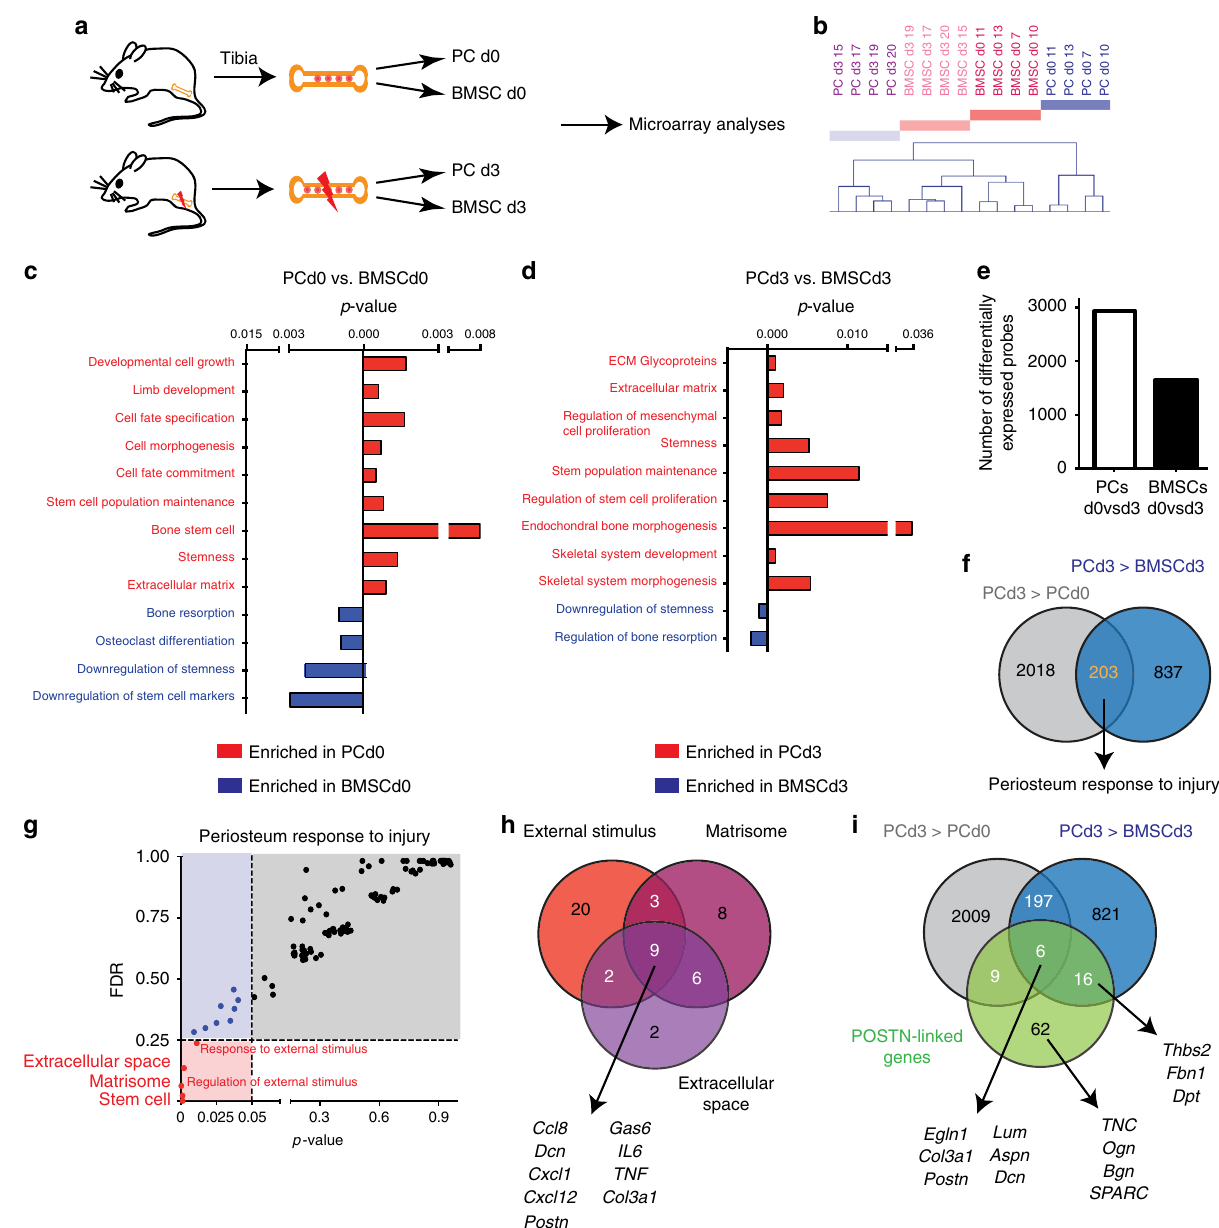
Fig. 4 Microarray analyses of PCs and BMSCs in response to fracture. a Experimental design for microarray analyses of PCs and BMSCs isolated from wild- type un-injured tibias (d0) and from tibias 3 days post fracture (d3) ( n = 4 per group). b Hierarchical clustering of biological replicates. c , d GSEA analyses of PCd0 vs. BMSCd0 and PCd3 vs. BMSCd3, respectively. PCs are enriched in stem cell, developmental, skeletal, and extracellular matrix gene sets (red) compared to BMSCs at both d0 and d3 (blue). e Number of differentially expressed probes in PCs and BMSCs in response to fracture. f Venn diagram showing the intersection of PCd3 vs. PCd0 and PCd3 vs. BMSCd3 representing the periosteum response to injury (PRI). g GSEA analysis of PRI genes. Red, blue, and gray boxes correspond to signi fi cant, interesting, and non-useful functions, respectively. Five signi fi cant functions are identi fi ed “ response to external stimulus, “ regulation of external stimulus ” , “ extracellular space ” , “ matrisome ” , and “ stem cell ” (red). h The GSEA signi fi cantly enriched GO categories “ response to external stimulus ” and “ regulation of external stimulus ” were merged into “ external stimulus ” and compared by Venn to the “ extracellular space ” and “ matrisome ” GO categories resulting in a list of 9 common genes. i Venn diagram shows the intersection of PRI and Postn -linked genes resulting in a list of 6 genes (Complete list of 93 Postn linked genes in Supplementary Table